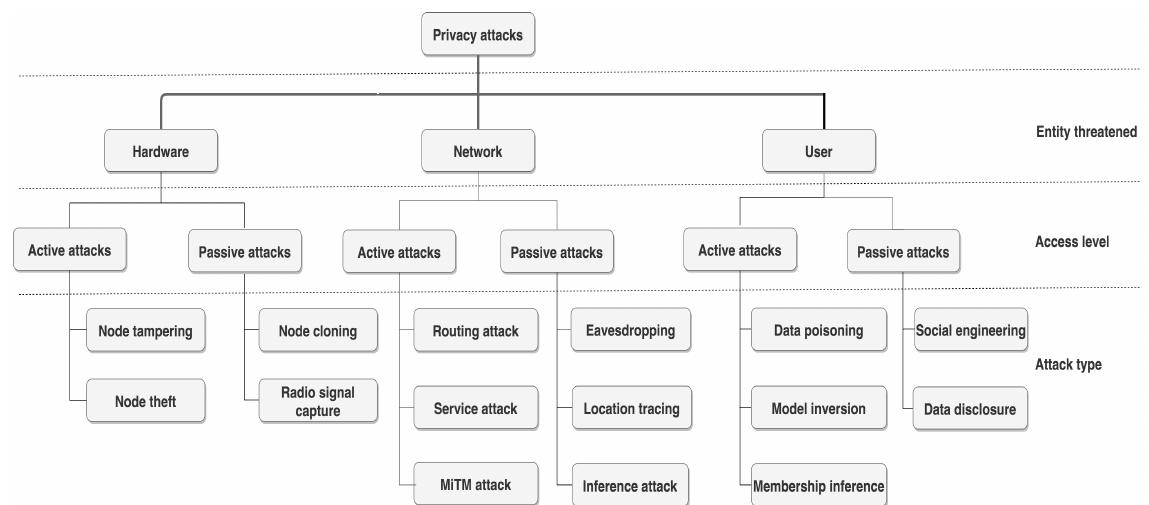
Figure 2. Taxonomy of privacy attacks on the smart home structured, according to the entities they target. Hardware layer attacks target the physical components; network layer attacks target the communication and connectivity; and user layer attacks target the smart home users. Attacks also compromise the software and data that are present across the different conceptual layers of the smart